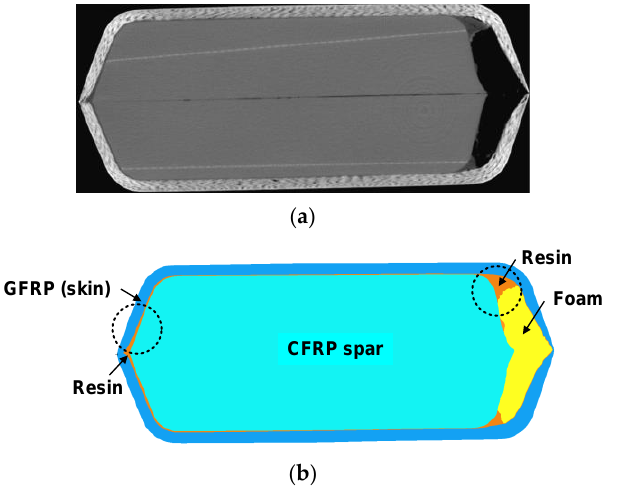
Figure 5. Comparison of section images at blade root station R2. ( a ) X-ray scan image and ( b ) section-segmented image.